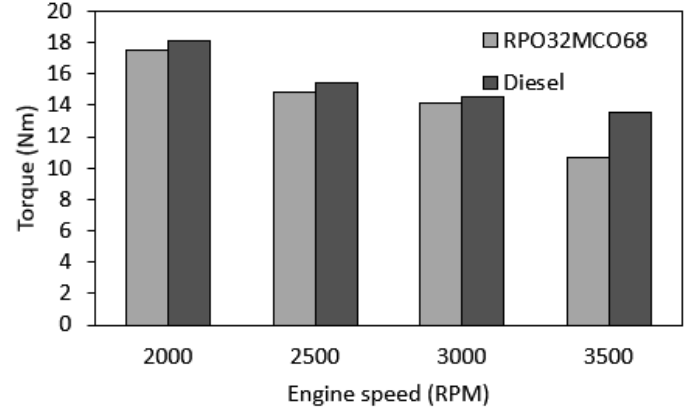
Figure 10. Comparison of engine torque as a function of engine speeds.